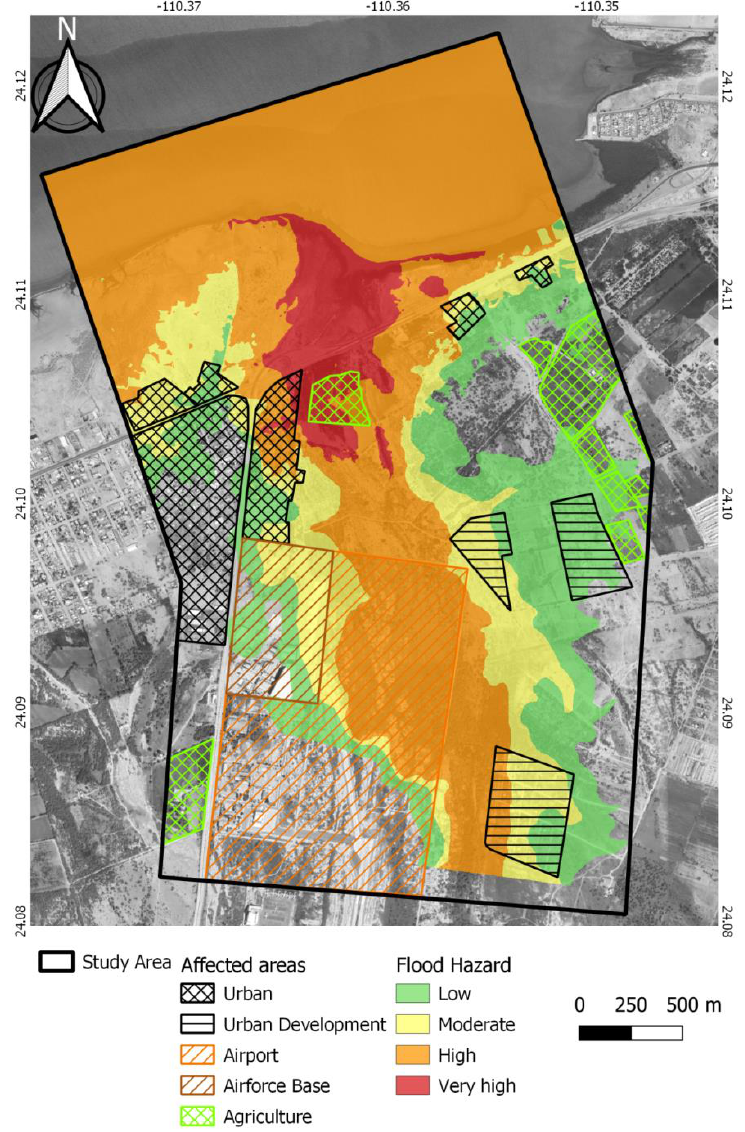
Figure 8. Runoff-Storm surge flood hazard map for study